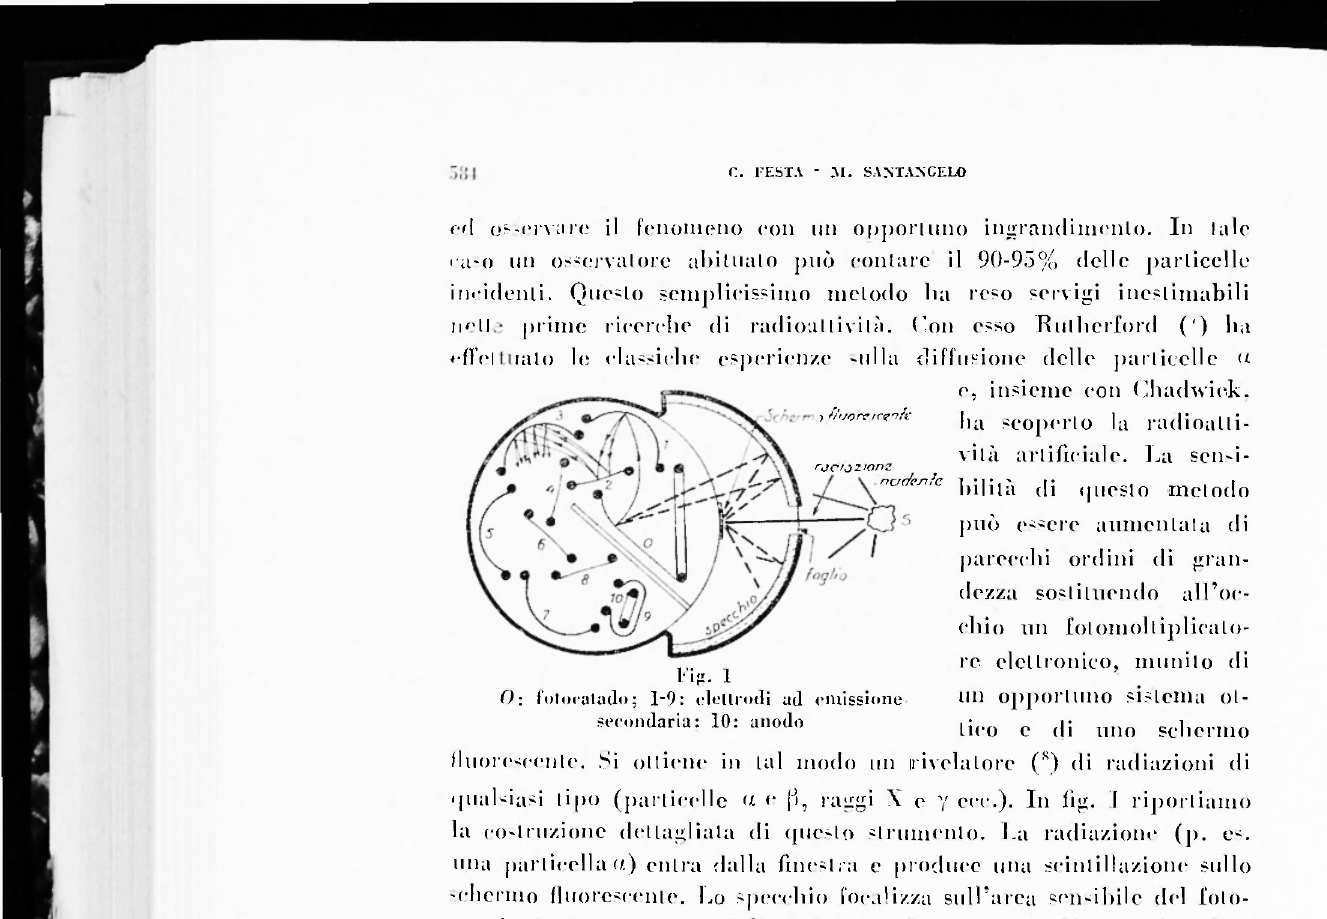
FIG. 1 O : fotocatado; 1-9: elettrodi ad